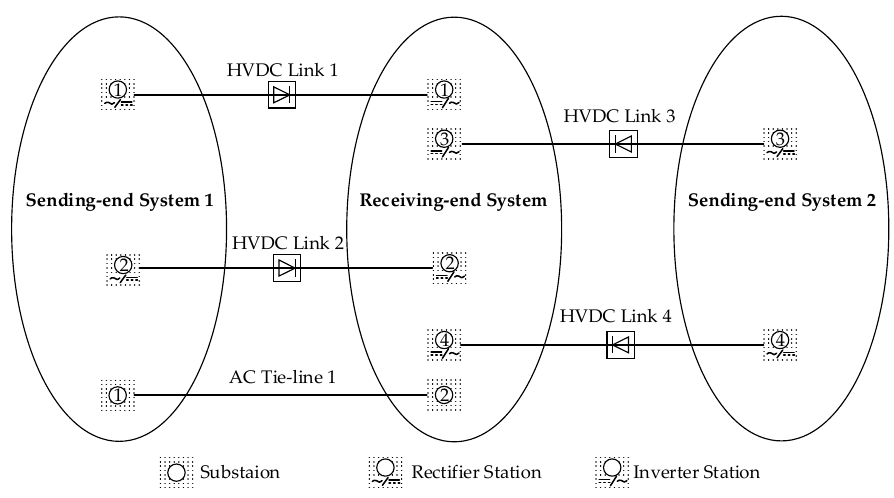
Figure 1. Schematic diagram of a multi ‐ infeed HVDC system.